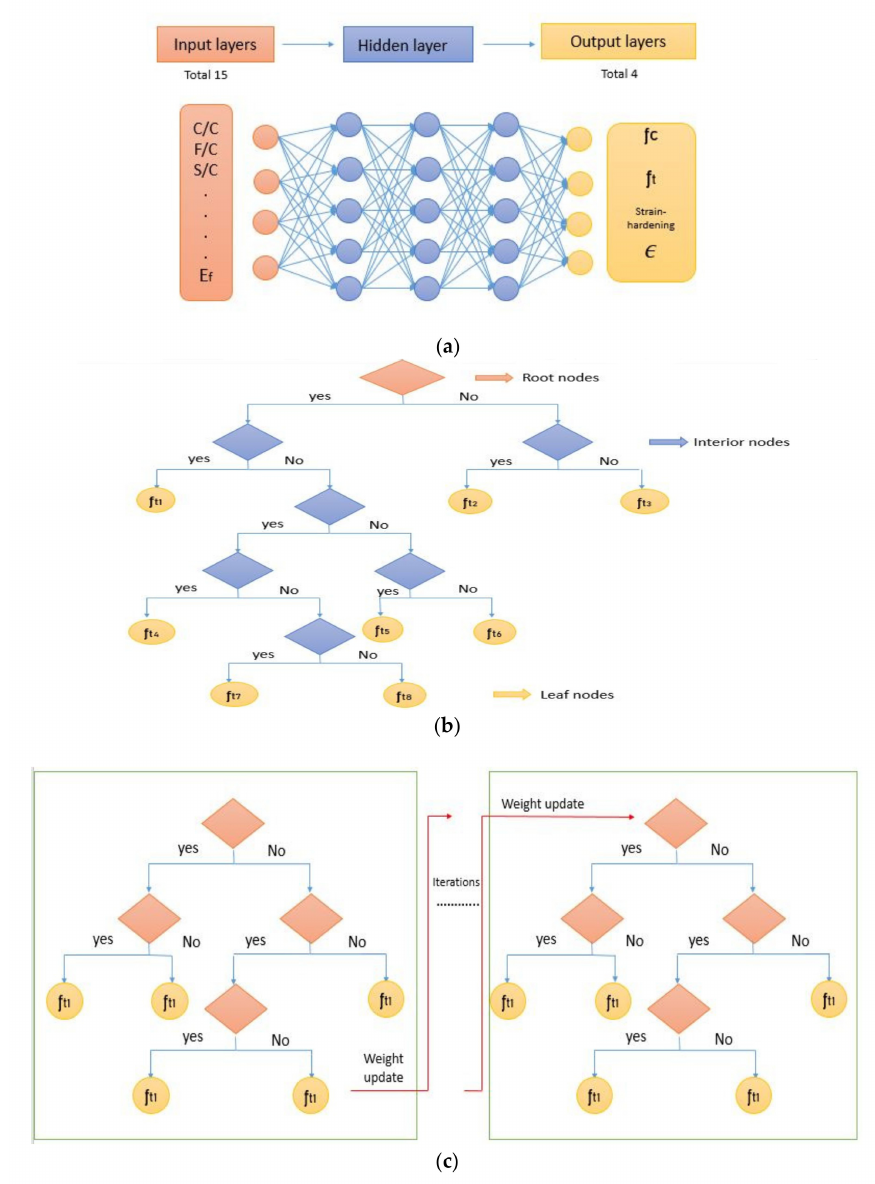
Figure 1. Machine Learning Models: ( a ) ANN; ( b ) CART; ( c ) XGBoost. f t is the Tensile strength; C/C is the cement-to-cement Ratio; F/C is the Fly ash to cement ratio; S/C is the sand to cement ratio; E f is the elastic modulus of fiber; f c is the Compressive Strength; є is the tensile Strain